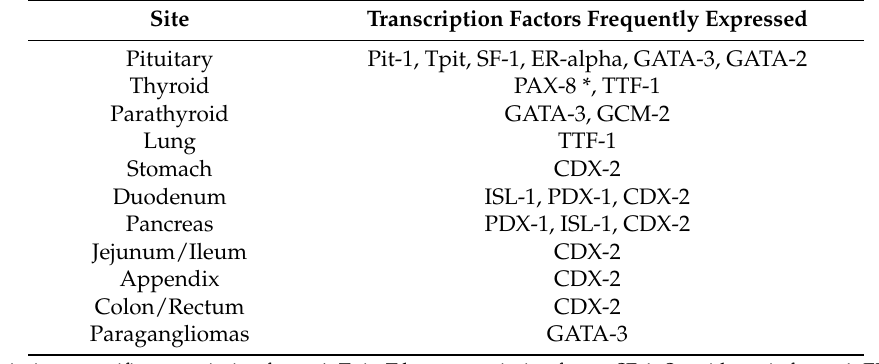
Table 1. Transcription Factors Distinguishing Various Neuroendocrine Neoplasms in the Differential Diagnosis of Paragangliomas in Unusual